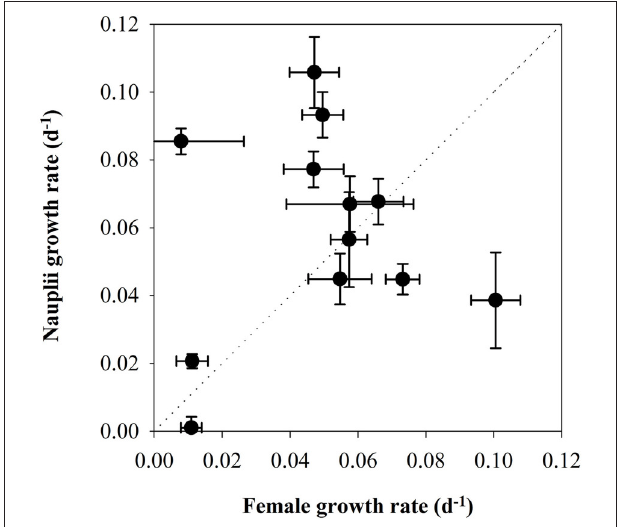
FIGURE 9 | Scatterplot of the secondary production in C. finmarchicus calculated from somatic growth in nauplii (d − 1 ) vs. secondary production calculated from egg production (d − 1